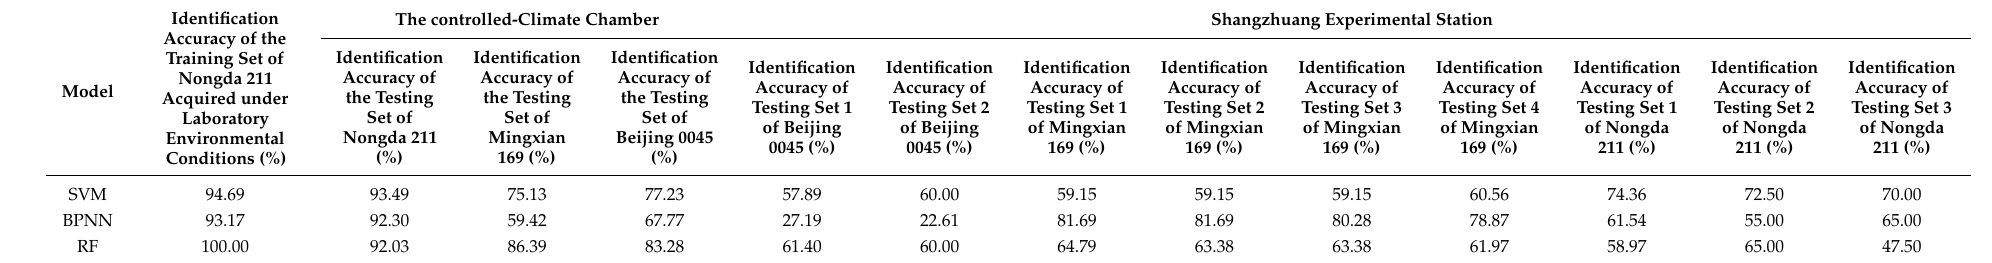
Table 16. Identification results for the individual-variety disease image testing sets acquired under laboratory environmental conditions and in the wheat field in Shangzhuang Experimental Station, and the additional testing set consisting of multi-variety disease images acquired in the wheat field in Gangu Testing Station using the SVM, BPNN, and RF models built based on the training set of the variety Nongda 211, itself consisting of disease images acquired under laboratory environmental conditions.